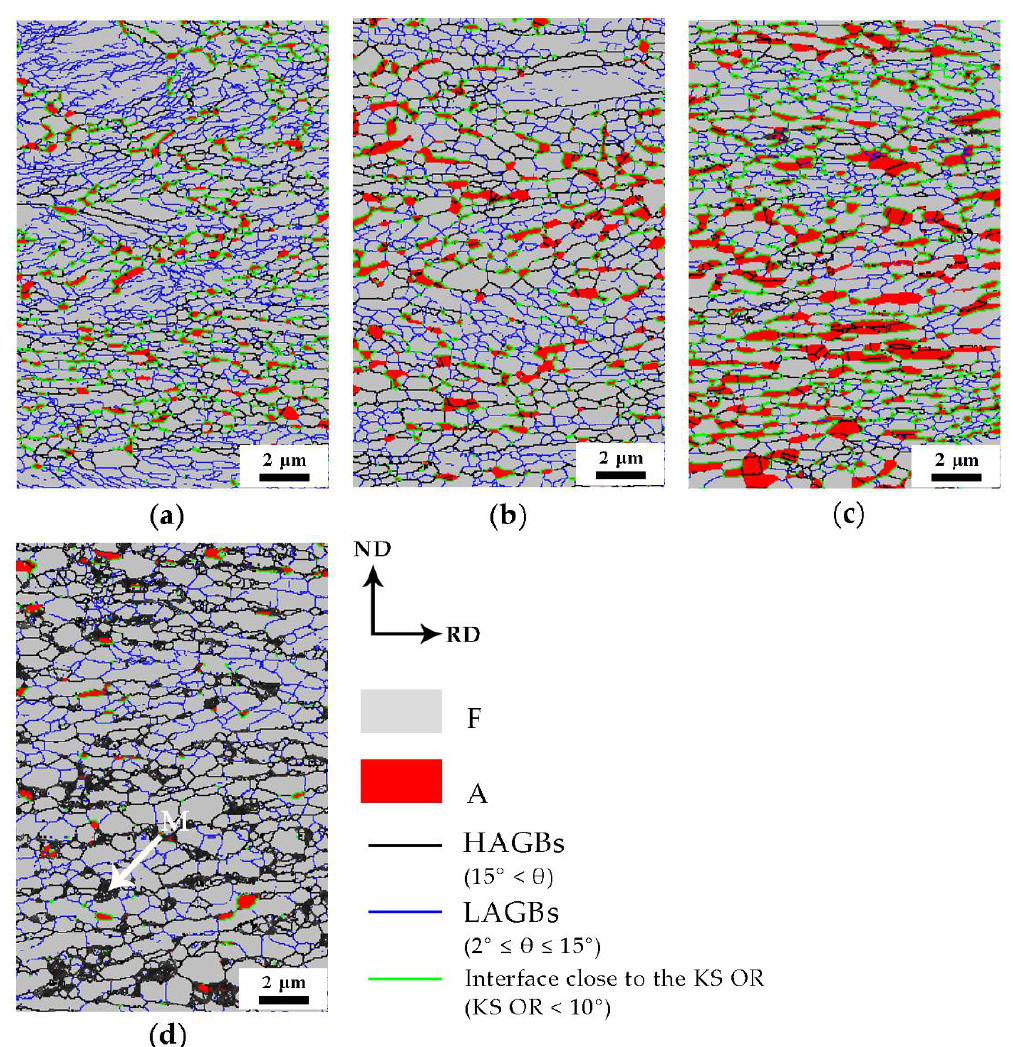
Figure 5. EBSD micrographs of samples ( a ) A650, ( b ) A675, ( c ) A700 and ( d )